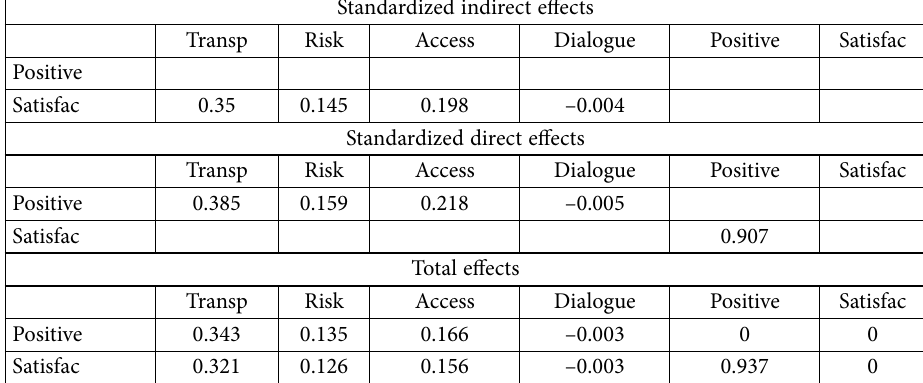
Table 7. Relationship